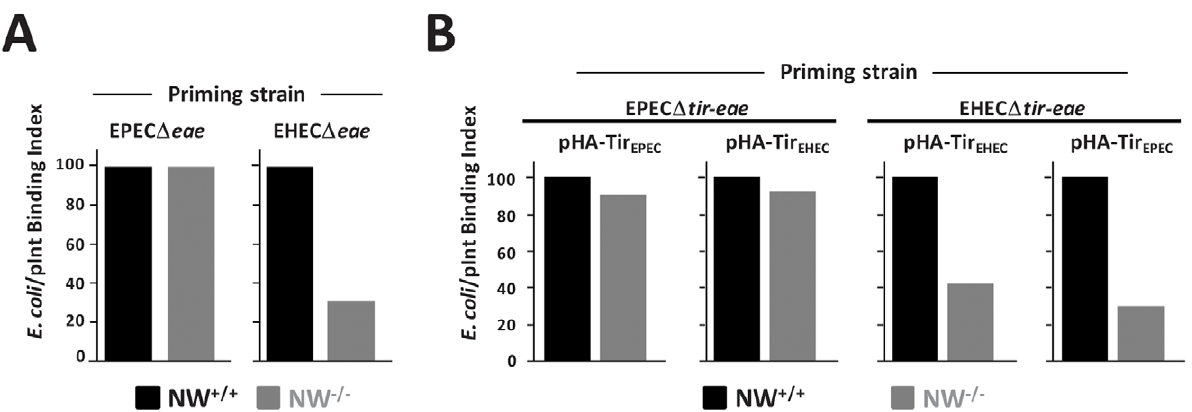
Figure 2. N-WASP is required for efficient intimin-mediated bacterial attachment to the cell surface. ( A ) A so-called ‘‘prime and challenge’’ assay was utilized to evaluate Tir/intimin-mediated binding of intimin-expressing E. coli to NW + / + or NW 2 / 2 FLCs. Cells were infected with EPEC D eae or EHEC D eae strains to allow for translocation Tir. After gentamicin treatment to kill EPEC and EHEC, Tir EPEC - and Tir EHEC -‘‘primed’’ cells were ‘‘challenged’’ (i.e. infected) for 1 hour, respectively with E. coli K12/pInt EPEC or K12/pInt EHEC that also harbor a plasmid encoding GFP and examined microscopically to detect bound bacteria. The bacterial binding index was defined as the percentage of cells with at least five bound bacteria. ( B ) NW + / + or NW 2 / 2 cells were infected with EPEC D tir-eae or EHEC D tir-eae harboring either pHA-Tir EPEC or pHA-Tir EHEC and the bacterial binding index determined as described as above. The experiments described in A and B were performed two times; data from one representative experiment are